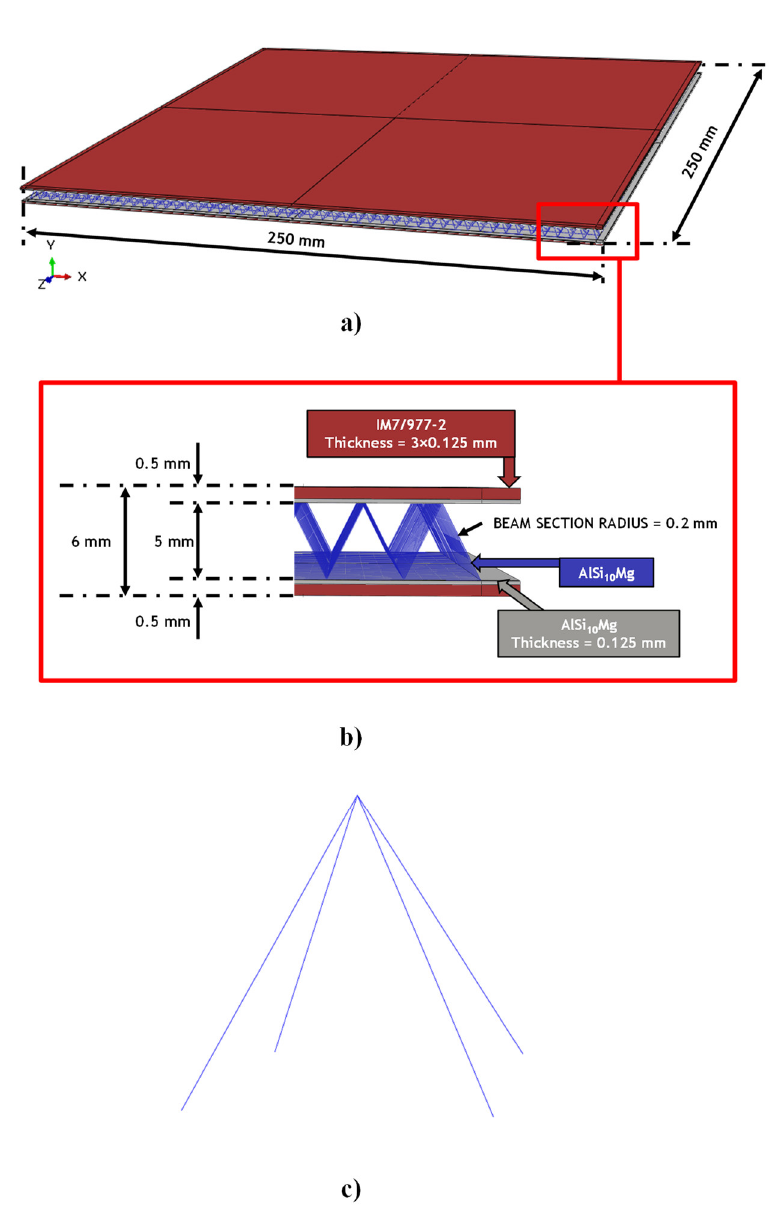
Figure 4. Numerical model of the shock absorber: ( a ) global view; ( b ) details; ( c ) view of the pyramidal unit cell.